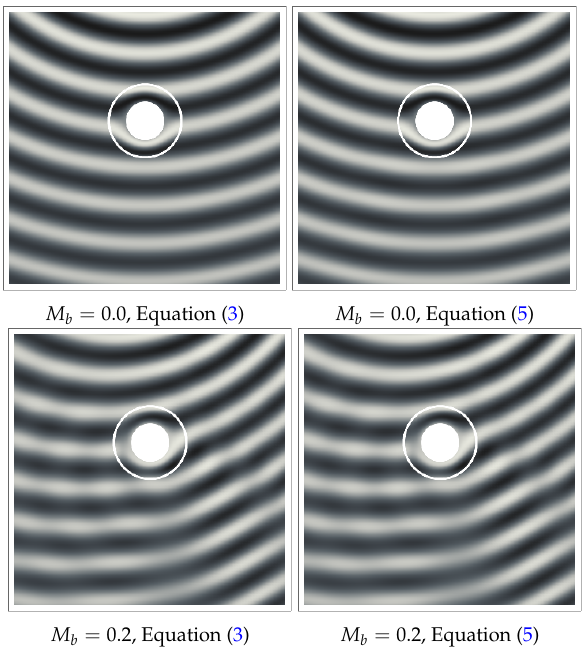
Figure 6. Field of total pressure in Ω c ∪ Ω h . Comparison of the results obtained with Equations (3) and (5) at ka = 6, for M b =